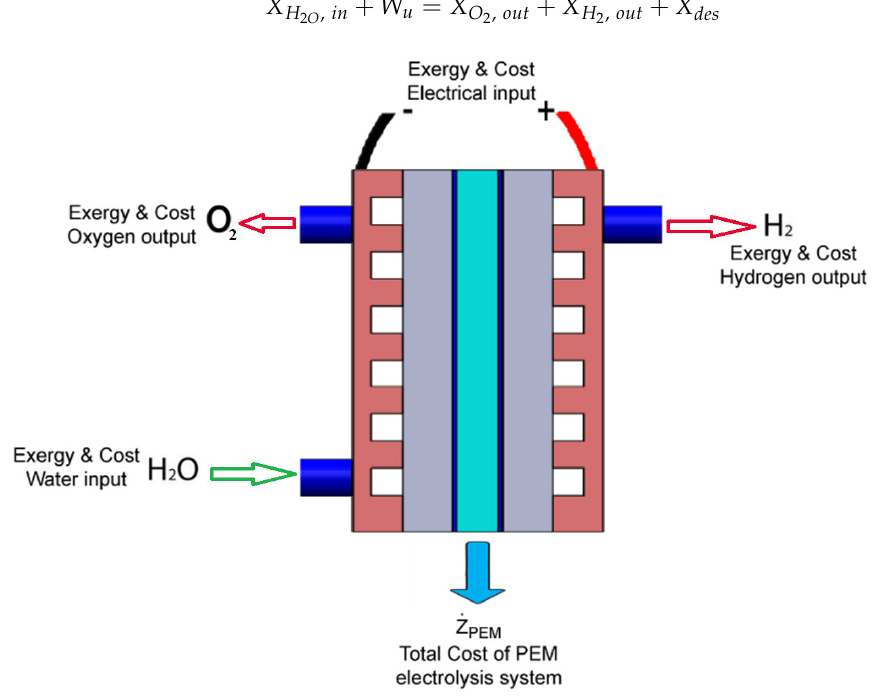
Figure 2. Components of exergy and exergoeconomic analysis for a PEMWE.